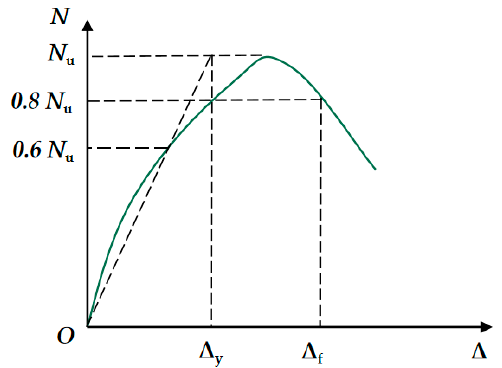
Figure 10. The meaning of the displacement ductility coefficient. Table 4. The test